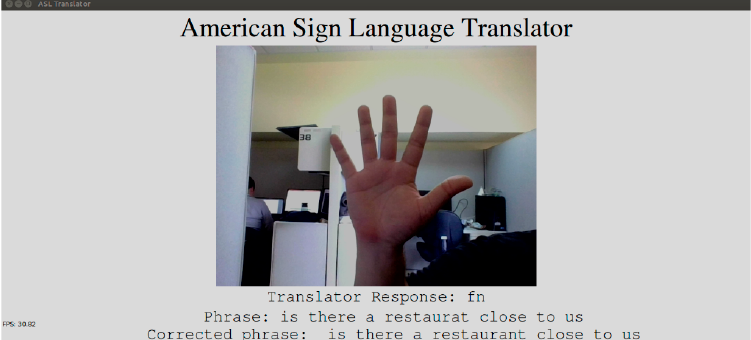
Figure 2. Proposed American Sign Language alphabet translator graphical user interface.